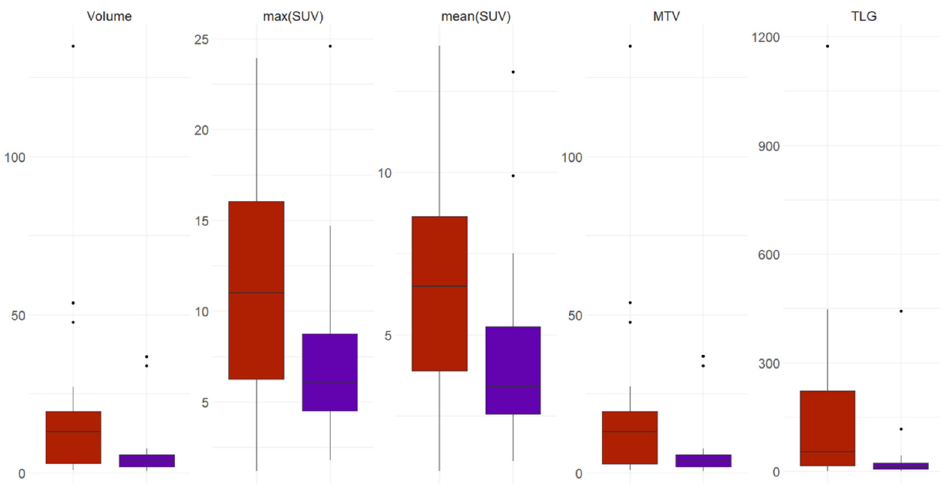
Figure 5. Box plots display the differences in volume and metabolic parameters (SUVmax, SUVmean, MTV and TLG) between the primary tumors (in red) and suspicious findings (purple) .